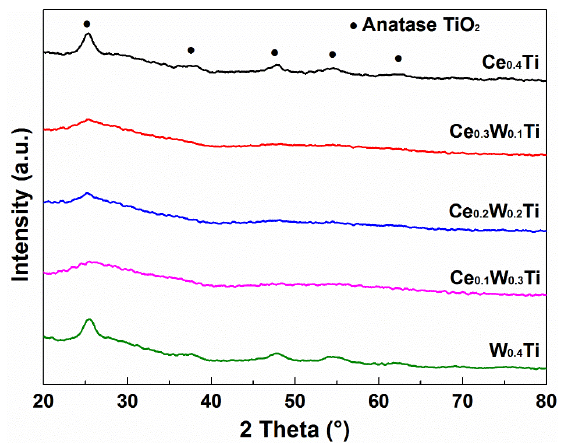
Figure 3. X-ray diffraction (XRD) patterns of the Ce-W-Ti catalysts.